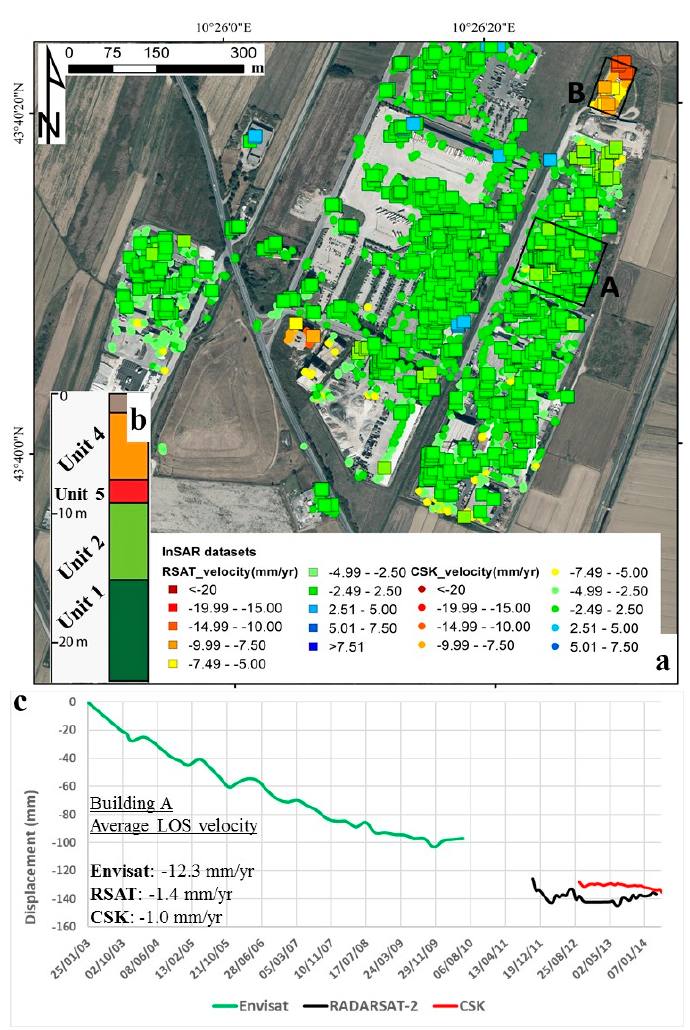
Figure 6. ( a ) LOS displacements affecting the Ospedaletto district. The displacement map is overlaid on a 2013 digital orthophoto; ( b ) Geological reconstruction of the stratigraphical asset, the classification is the one proposed by Sarti et al. [43]; ( c ) Envisat, RADARSAT-2 and COSMO-SkyMed